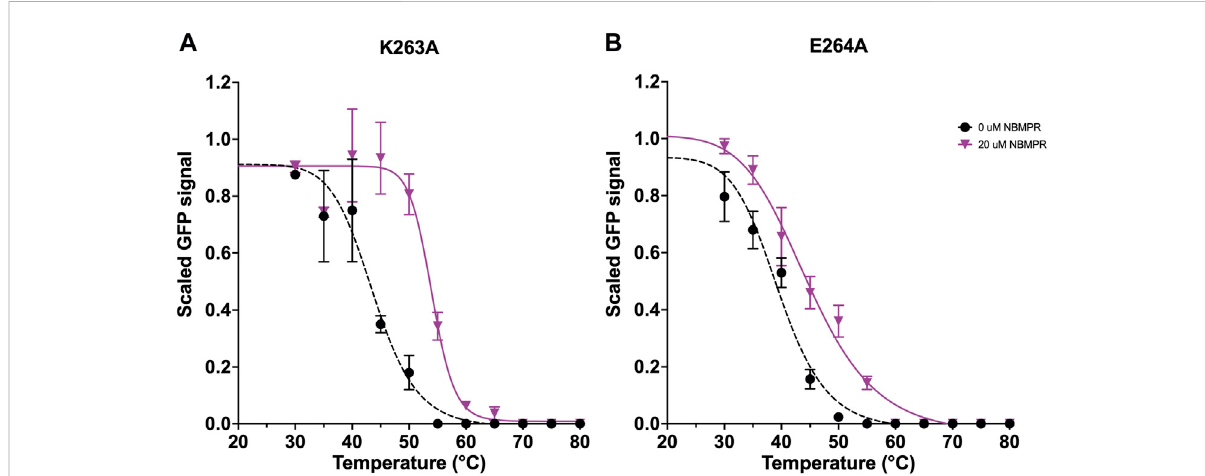
FIGURE 6 Investigation of variants K263A and E264A stabilisation of hENT1. Data generation, fi tting and error analysis performed as detailed for wild type. (A) K263A apo -state curves were collected as an average of 5 repeats, whereas NBMPR-bound curves were collected as an average of 3 repeats. (B) E264A apo -state curves were collected as an average of 7 repeats, whereas NBMPR-bound curves were collected as an average of 3